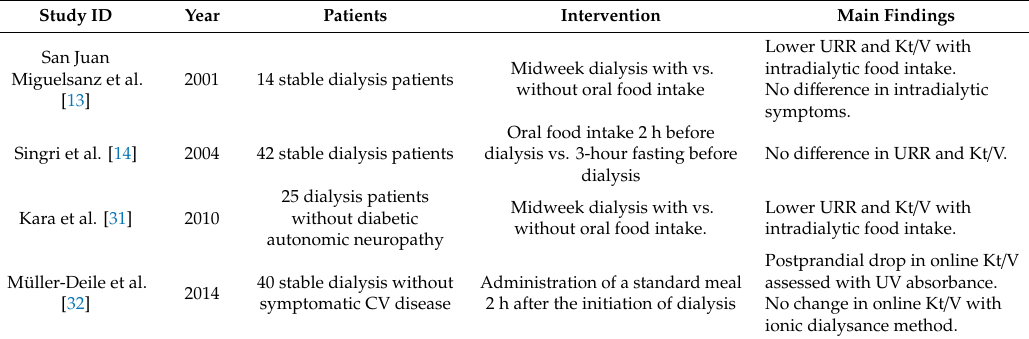
Table 2. Clinical studies investigating the e ff ect of intradialytic food intake on the adequacy of delivered